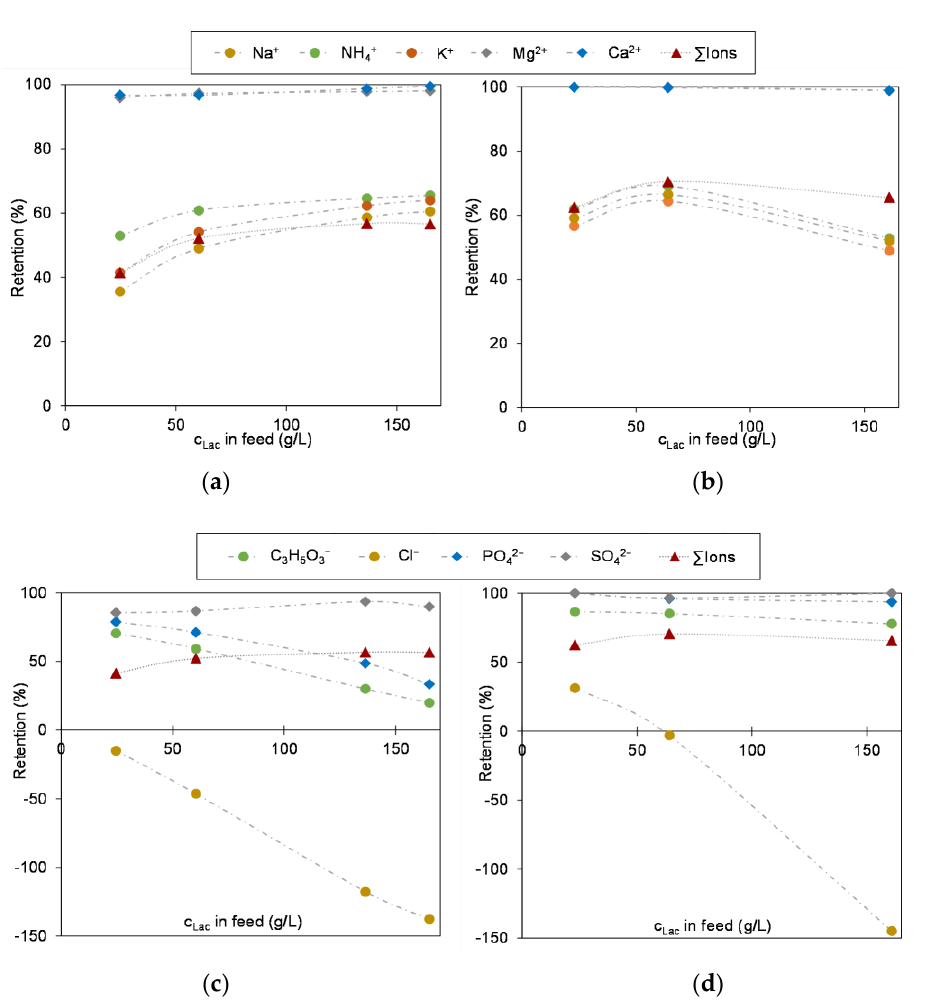
Figure 8. Retention of ions during concentration of lactose in whey permeate; ( a ) cations, membrane: XN45; ( b ) cations, membrane: NFS; ( c ) anions, membrane: XN45; ( d ) anions, membrane: NFS. Operation parameters summarized in Table